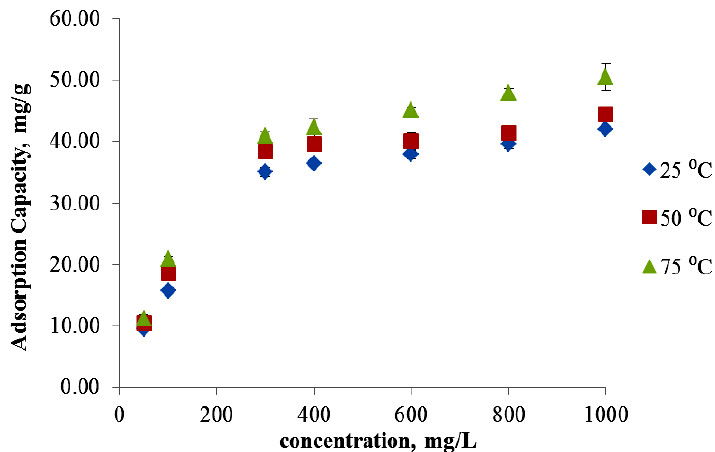
Figure 4. Effect of initial concentration of nickel ions on adsorption capacities by peh-g-opefb at different